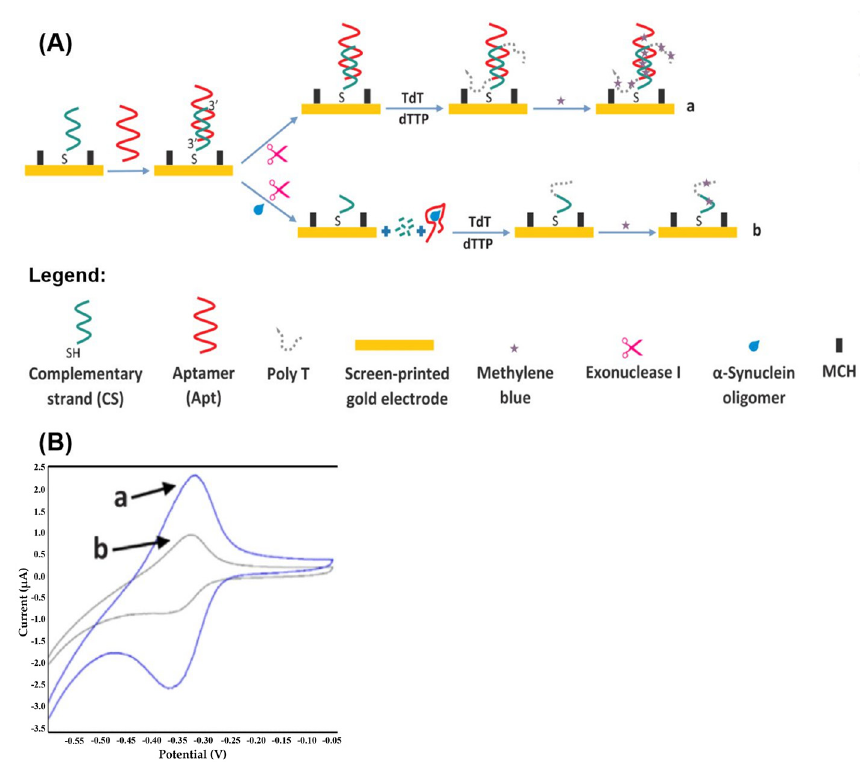
Figure 1. ( A ) Schematic illustration of voltammetric detection of α -syn oligomers. ( B ) CV curves obtained for the sensing platform (a) in the absence and (b) in the presence of α -syn oligomers. Measurements were carried out in PBS solution, scanning from − 0.6 V to − 0.05 V at a scan rate of 100 mV/s. Reprinted with permission from Ref. [102].